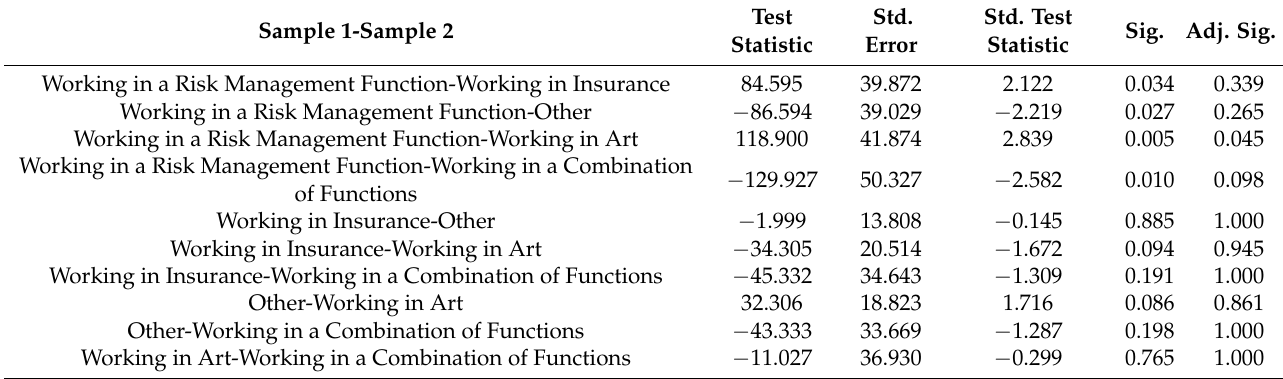
Table 16. Post hoc analysis—fluctuation in the value of art.